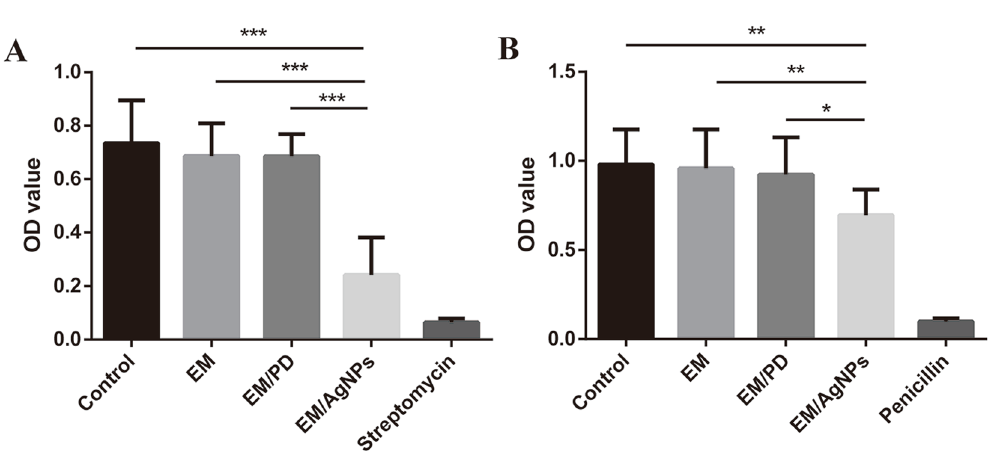
Figure 6. Evaluation of antibacterial activity against ( A ) E. coli and ( B ) S. aureus by the disc diffusion method using discs of (a) filter paper, (b) EM, (c) EM/PD and (d) EM/AgNPs. ( C ) Measurement of ZOI of EM/AgNPs against E. coli and S. aureus . The values are shown as the mean ± SD (n = 6).